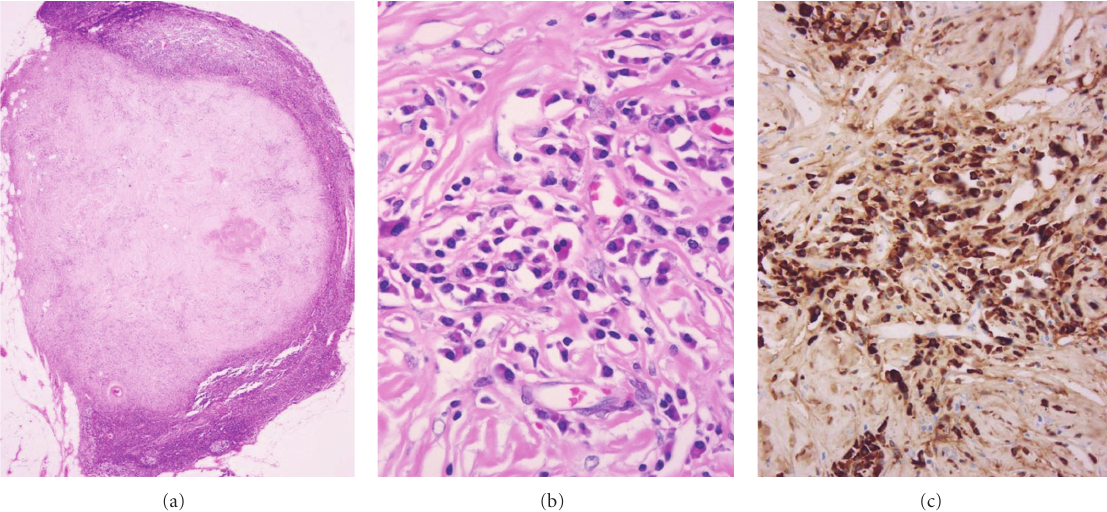
Figure 5: IgG4-related lymphadenopathy (type V). This is a regional lymph node with IgG4-related cholangitis. (a) The majority of the lymph node is replaced by hyalinized fibrous tissue. (b) Mature plasma cells infiltrate the hyalinized fibrous tissue. (c) The mature plasma cells are IgG4 + .